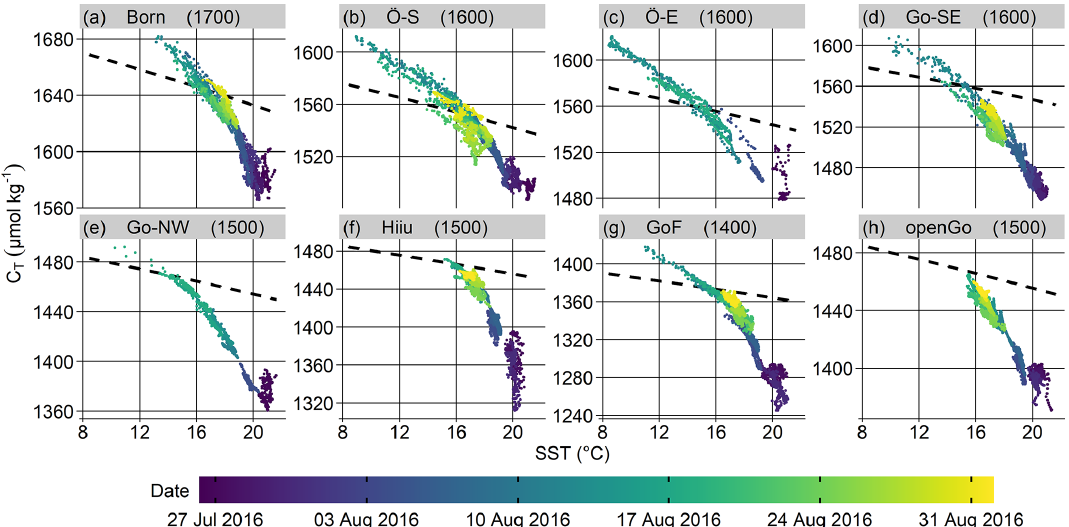
Figure B5. Surface C T estimated from p CO 2 as measured by SOOP Finnmaid on 21 transects from 26 July to 30 August 2016, each plotted against SST within the seven upwelling regions and the open Gotland Sea box for comparison. We estimated A T for each box (values in µmolkg − 1 in parentheses) based on Müller et al. (2016). The measurement date is colour-coded. Temporal coverage in the Go-SE box (15 transects) and the Ö-E and Go-NW boxes (6 transects) is reduced since SOOP Finnmaid uses two different routes around Gotland. Dashed black lines indicate atmospheric-equilibrium C T (calculated using mean salinity per box in the given time